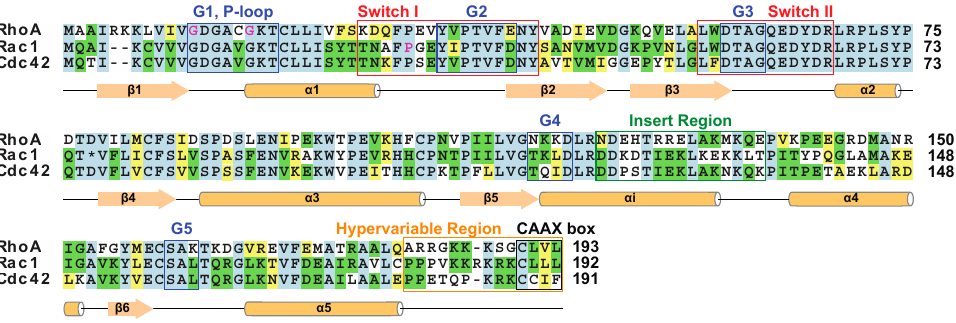
Figure 1. Rho family sequence alignment.